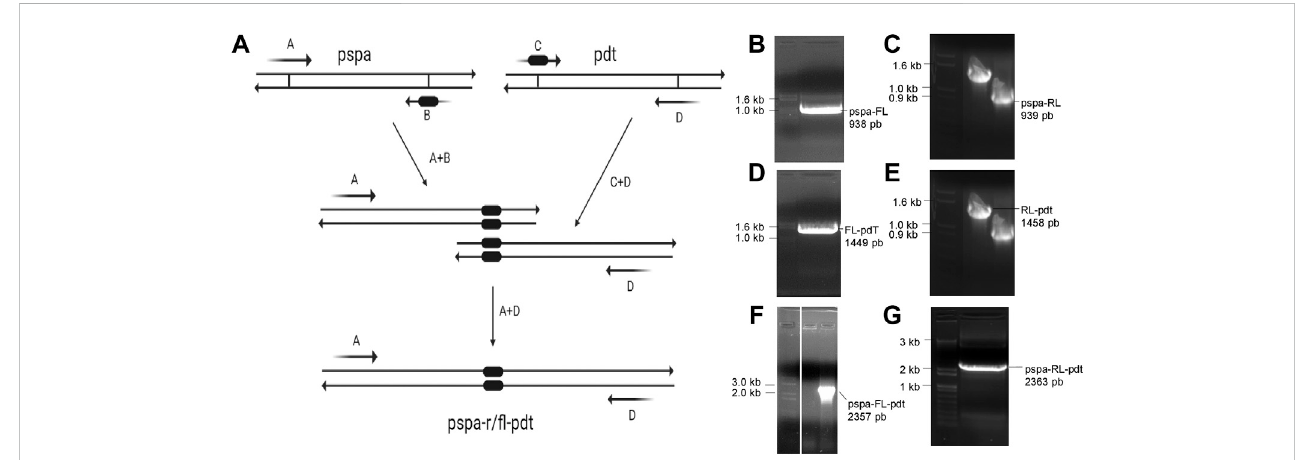
FIGURE 3 Overlap extension PCRscheme andagarosegelswith PCRproducts. (A) Mechanismofmolecular linker insertion byoverlapextension PCR.Theprimers (A – D) used in each reaction are shown in Table 1. (B, C) Fragments of pspa ampli fi ed with a part of fl exible linker (FL) and rigid linker (RL), respectively. (D, E) Fragments of pdt ampli fi ed with a part of FL and RL, respectively. (F, G) PCR product after ampli fi cation of complete pspa-FL-pdt and pspa-RL-pdt , respectively.